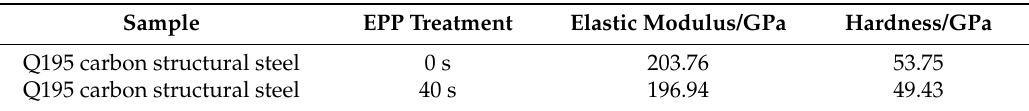
Table 1. The mean elastic modulus and hardness of Q195 carbon structural steel before EPP and after EPP treatment for 40 s.